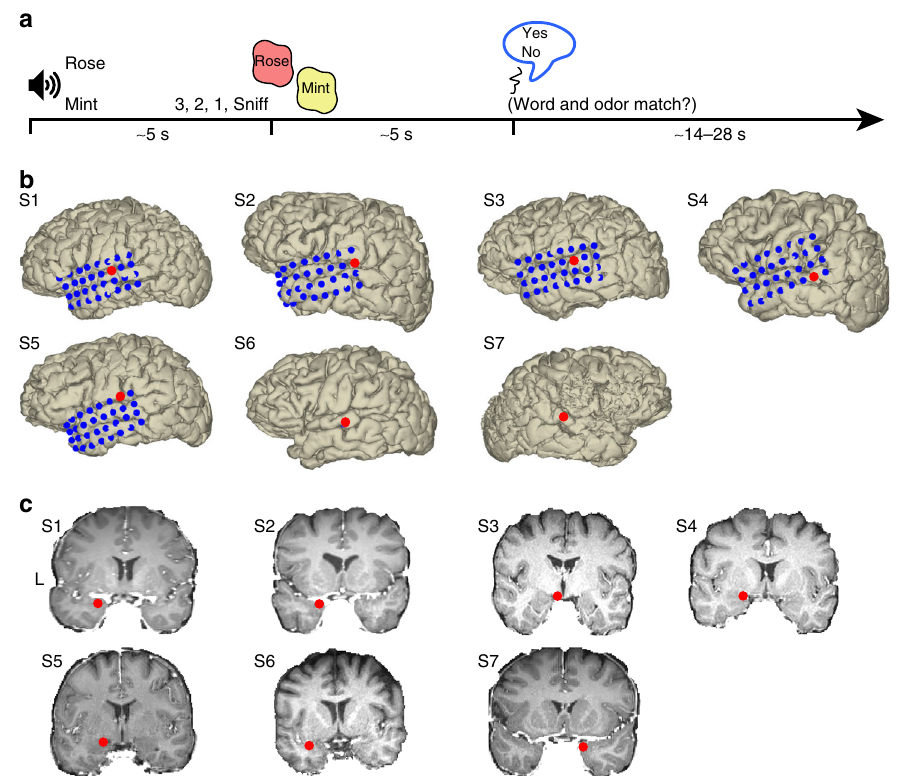
Fig. 1 Experimental design and electrode locations. a Auditory – olfactory matching task. Each trial began with a computerized, spoken descriptive word (rose or mint), followed ~5 s later by the presentation of an odor. After smelling the odor, participants verbally indicated whether the odor matched the word. A trial was considered correct if the participant responded "yes" when the odor matched the cue or "no" when the odor did not match the cue. b , c Electrode locations. Red dots on individual subject brains indicate electrodes located in the superior temporal gyrus ( b ) and piriform cortex ( c ) for each participant (S1 – S7). Blue dots in b show the entirety of implanted parietal grids (S1 – S5). S6 and S7 had depth wires implanted with an electrode in superior temporal gyrus. L left